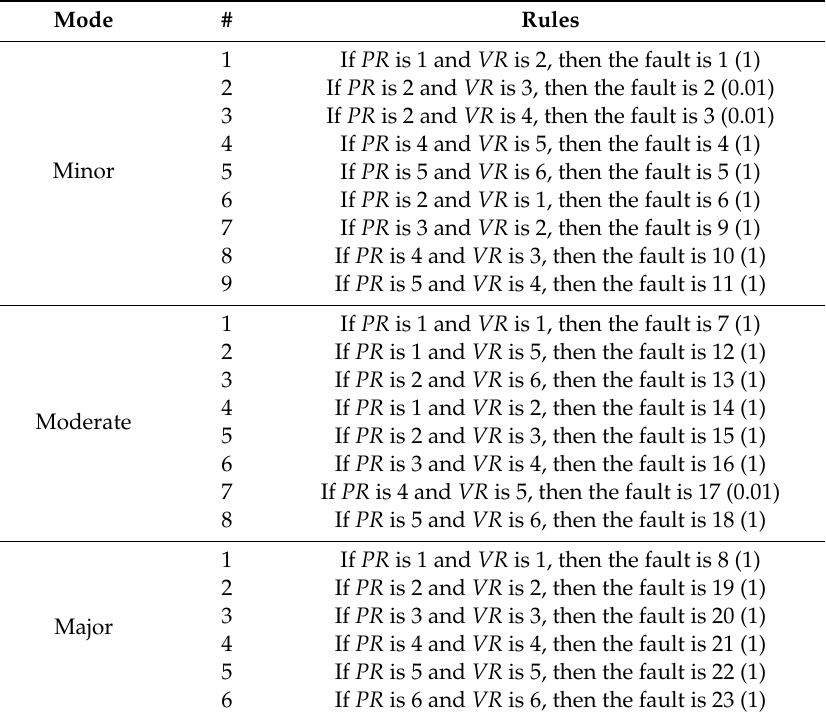
Table 4. Fuzzy logic